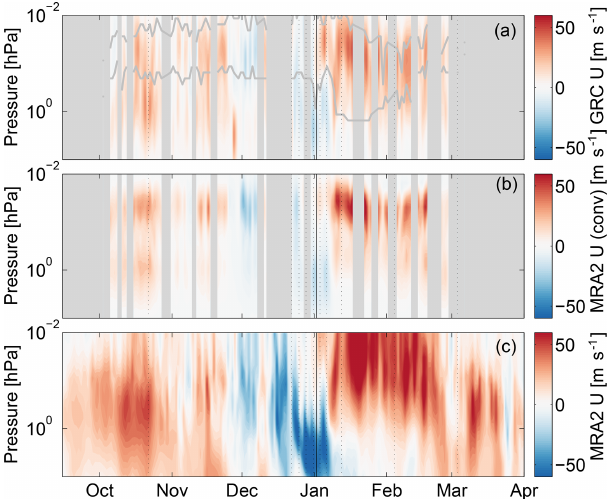
Figure 2. Zonal wind at Ny-Ålesund measured with GROMOS- C (a) and from the MERRA-2 reanalysis convolved with the aver- aging kernels of GROMOS-C (b) and unconvolved (c) for winter 2018/2019. The grey background indicates data gaps and the grey lines indicate the area where the measurement response is larger than 0.5. The dotted lines indicate the dates of the polar vortex snap- shots in Fig. 6 and the solid line shows the central date of the SSW.